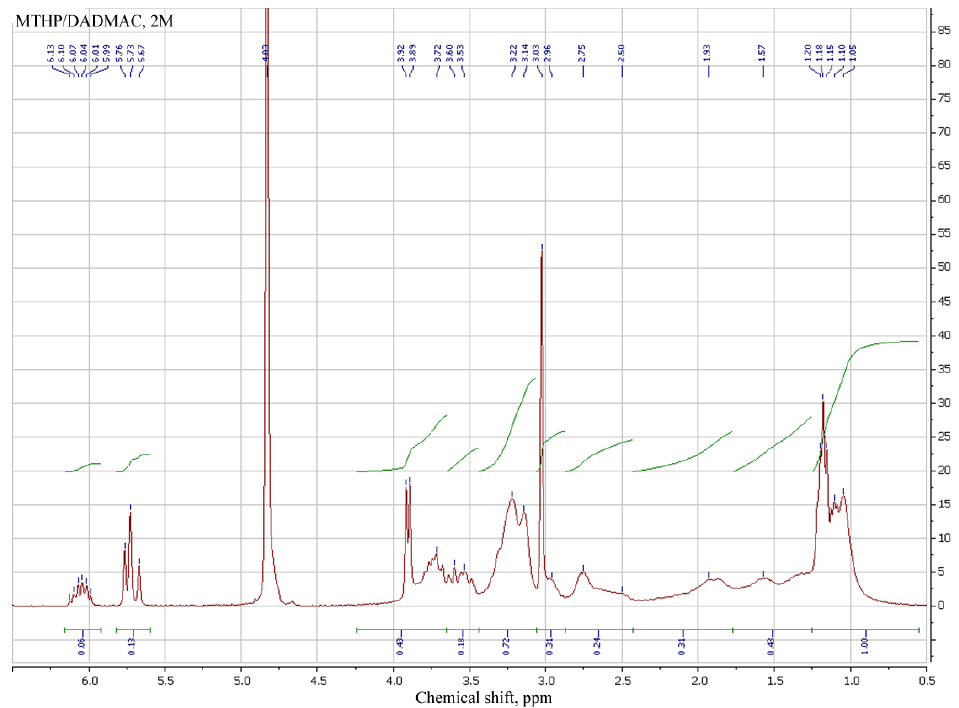
Figure 5. NMR 1 H spectrum of MTHP/DADMAC copolymer in deuterated water (soluble fraction after dialysis, [M] Σ 2 = 2M).